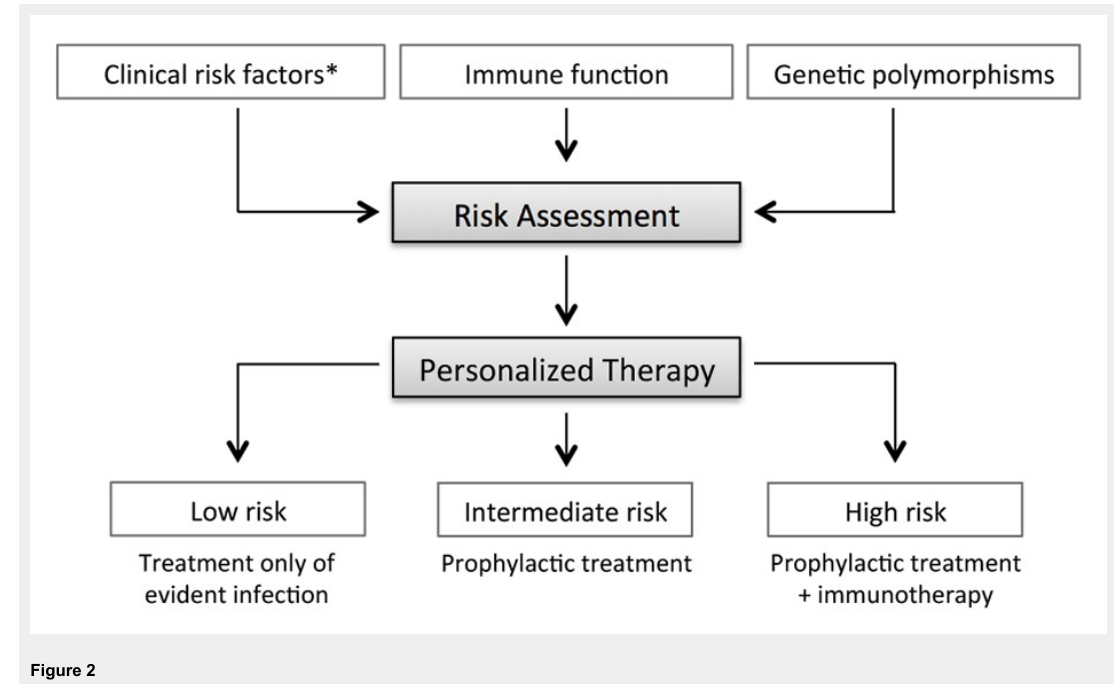
Figure 2 Possible risk assessment and personalised therapy scheme for patients at risk for invasive fungal infections. *Clinical risk factors include graft-versus-host disease, steroid treatment, T cell-depleted graft and acute myeloid leukemia.